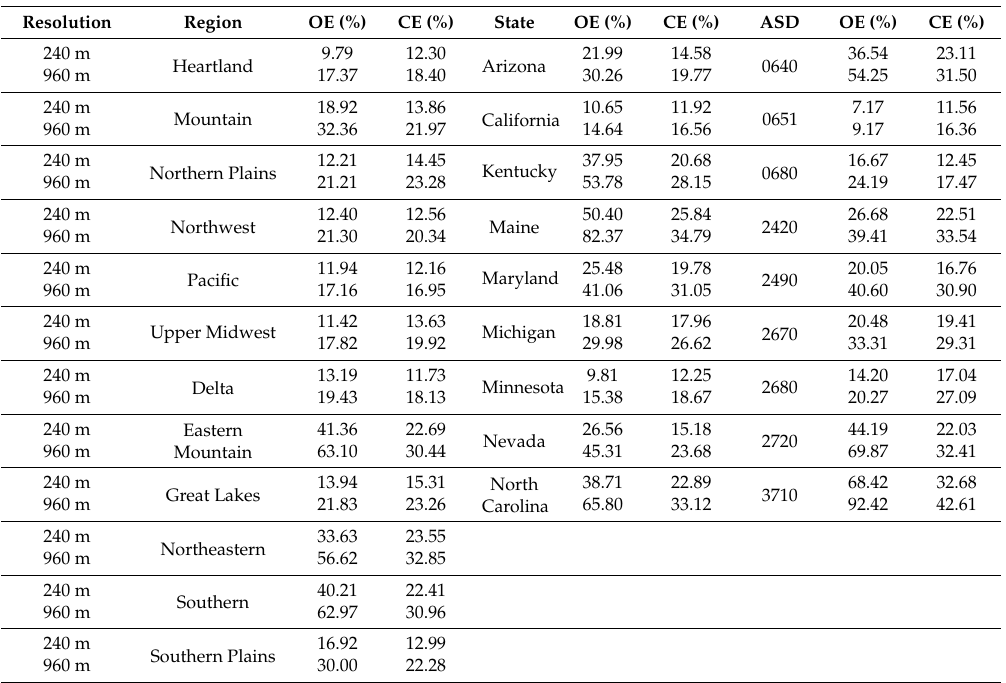
Table 6. The Omission Error (OE) and Commission Error (CE) for the crop map class in the upscaled maps for all study